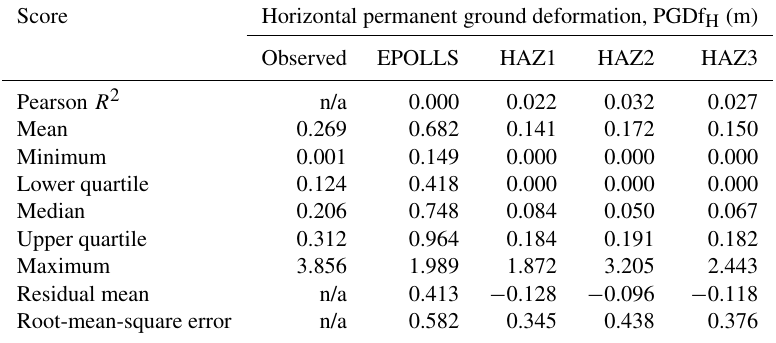
Table 9. Summary statistics of horizontal permanent ground deformation (PGDf H ) estimates for Darfield and Christchurch earthquakes from EPOLLS and HAZUS models. Refer to Table 4 for descriptions corresponding to model